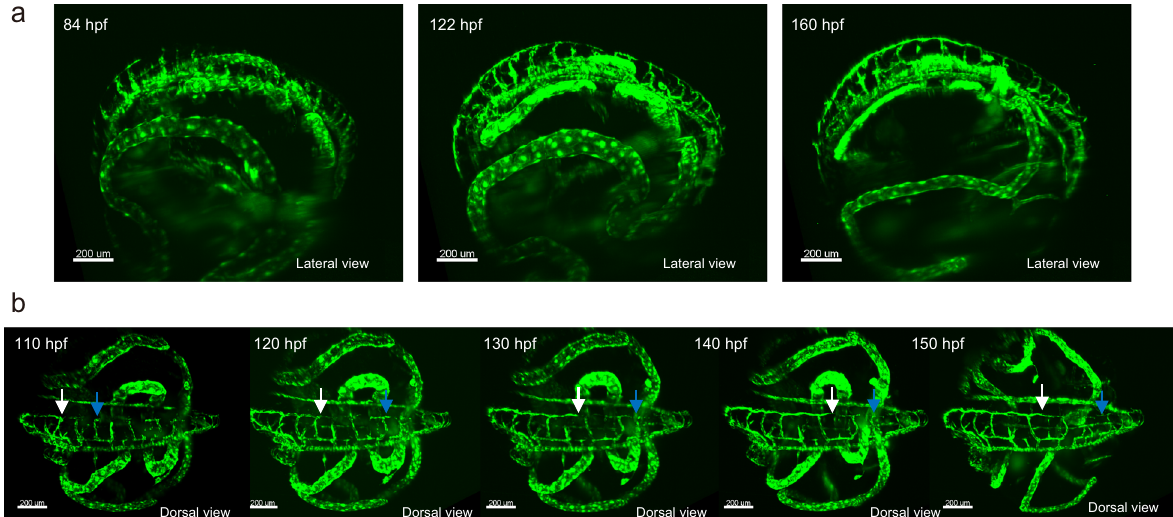
Fig. 7 Long-term time-lapse imaging of developing embryos. a Snapshot images of lymphatic vessel development in a FLT4-GFP embryo for stages of 84, 122, and 160 hpf. Embryo is embedded into 1% hollow agarose gel fi lled with 0.03% seawater. b Detailed time-lapse observation of the lymphatic endothelial cell migration. White arrows indicate migration front, while blue arrows indicate migrating cells from the intersegmental lymphatics. ( a , b ) n = 2 biologically independent embryos are subjected to the analysis.